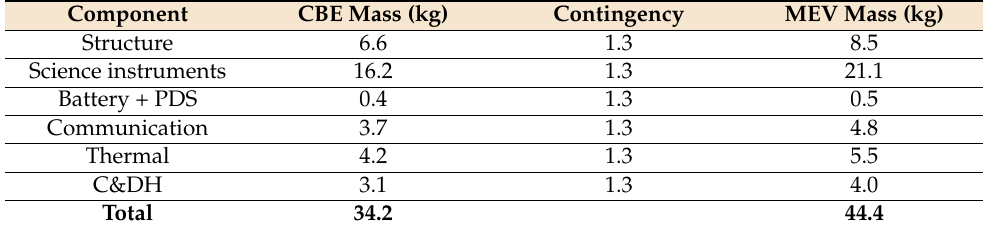
Table 7. Mass breakdown of the probe containing the LDMS instrument.